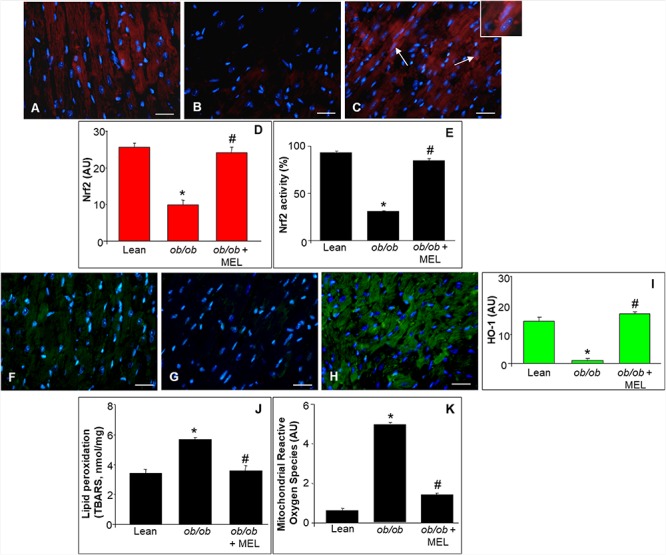
Immunofluorescence photomicrographs of Nrf2 (A–C) and HO-1 (F–H) expression in hearts of lean (A,F), ob/ob mice (B,G), and ob/ob mice supplemented with melatonin (C,H). Scale bar: 20 μm. The graphs summarize Nrf2 immunomorphometrical evaluation (D), Nrf2 activity (E), HO-1 immunomorphometrical measurement (I), heart lipid peroxidation (J), and mitochondrial reactive oxygen species analysis (K). *p≤0.05 vs lean mice and #p≤0.05 vs ob/ob mice. HO-1, heme oxygenase-1; MEL, melatonin; Nrf2, nuclear factor erythroid-derived 2-like 2; TBARS, thiobarbituric acid reactive substance.